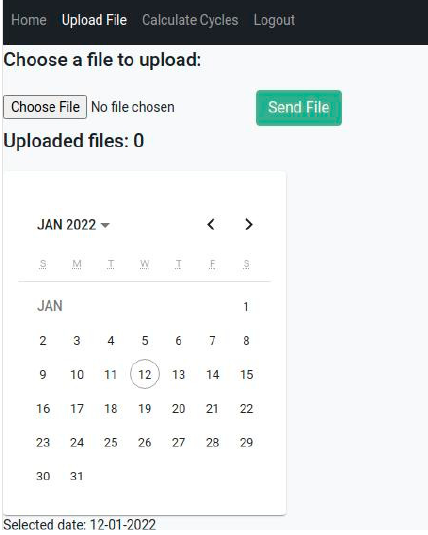
Figure 5. Upload file